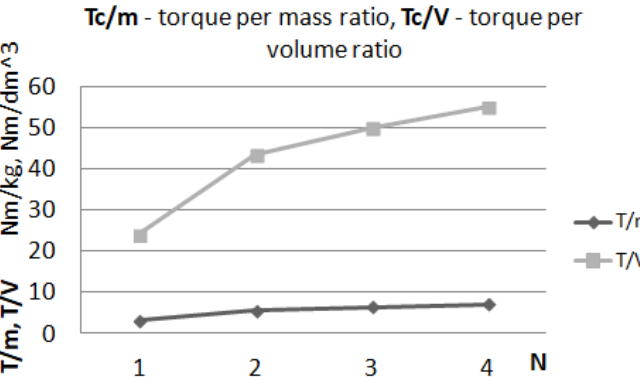
Figure 16. Torque per mass ratio T c / m and torque per volume ratio T c / V vs. number of discs